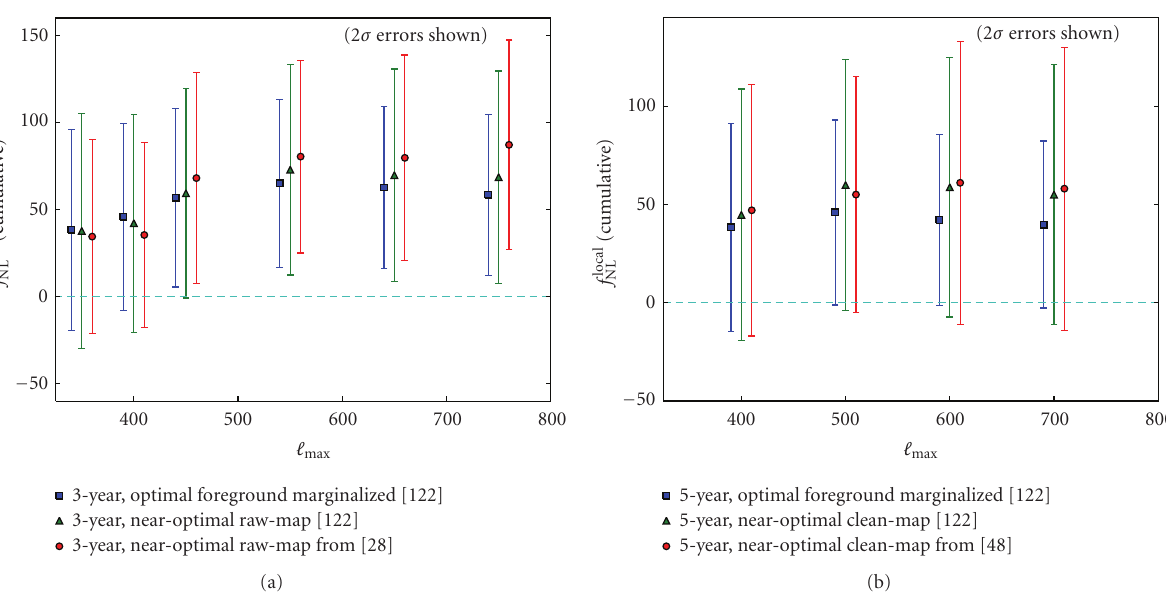
Figure 6: (a) Constraints on local f NL using WMAP 3-year data as a function of maximum multipole (cid:8) max used in the analysis. The red circles are the results obtained using near optimal estimator by Yadav and Wandelt [28]. The green triangles are using the the near-optimal estimator by Smith et al. [122]. The blue square results are obtained using either the optimal estimator by Smith et al. [122]. For all the three analysis Kp0 mask was used. (b) Comparison between the 5-year results (optimal estimator, raw maps) reported in Komatsu et al. [48] and results obtained using the optimal or suboptimal estimator by Smith et al.